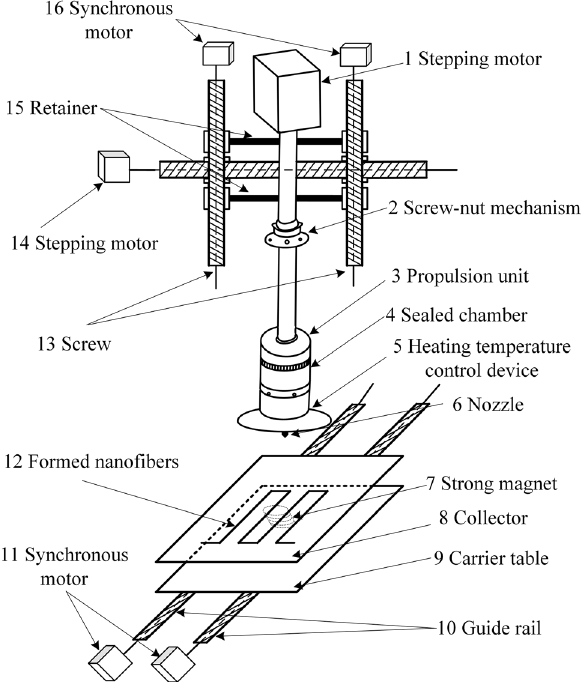
Figure 8. Three-dimensional mobile MMS device.